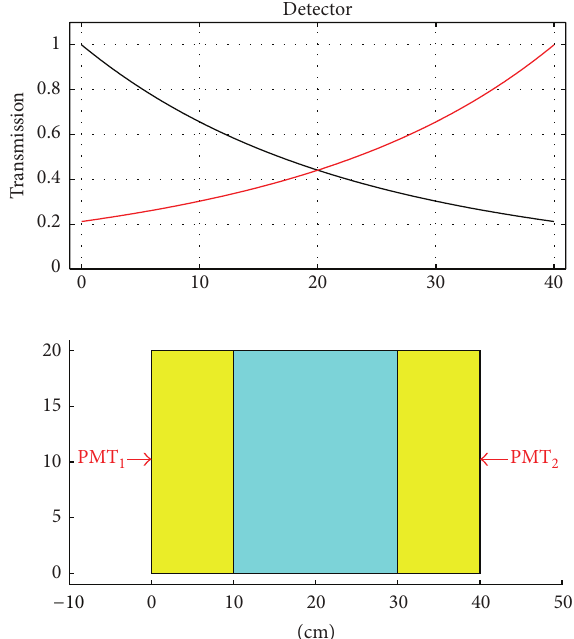
Figure 11: Transmission and sensitive area in the detector 20 × 20 cm 2